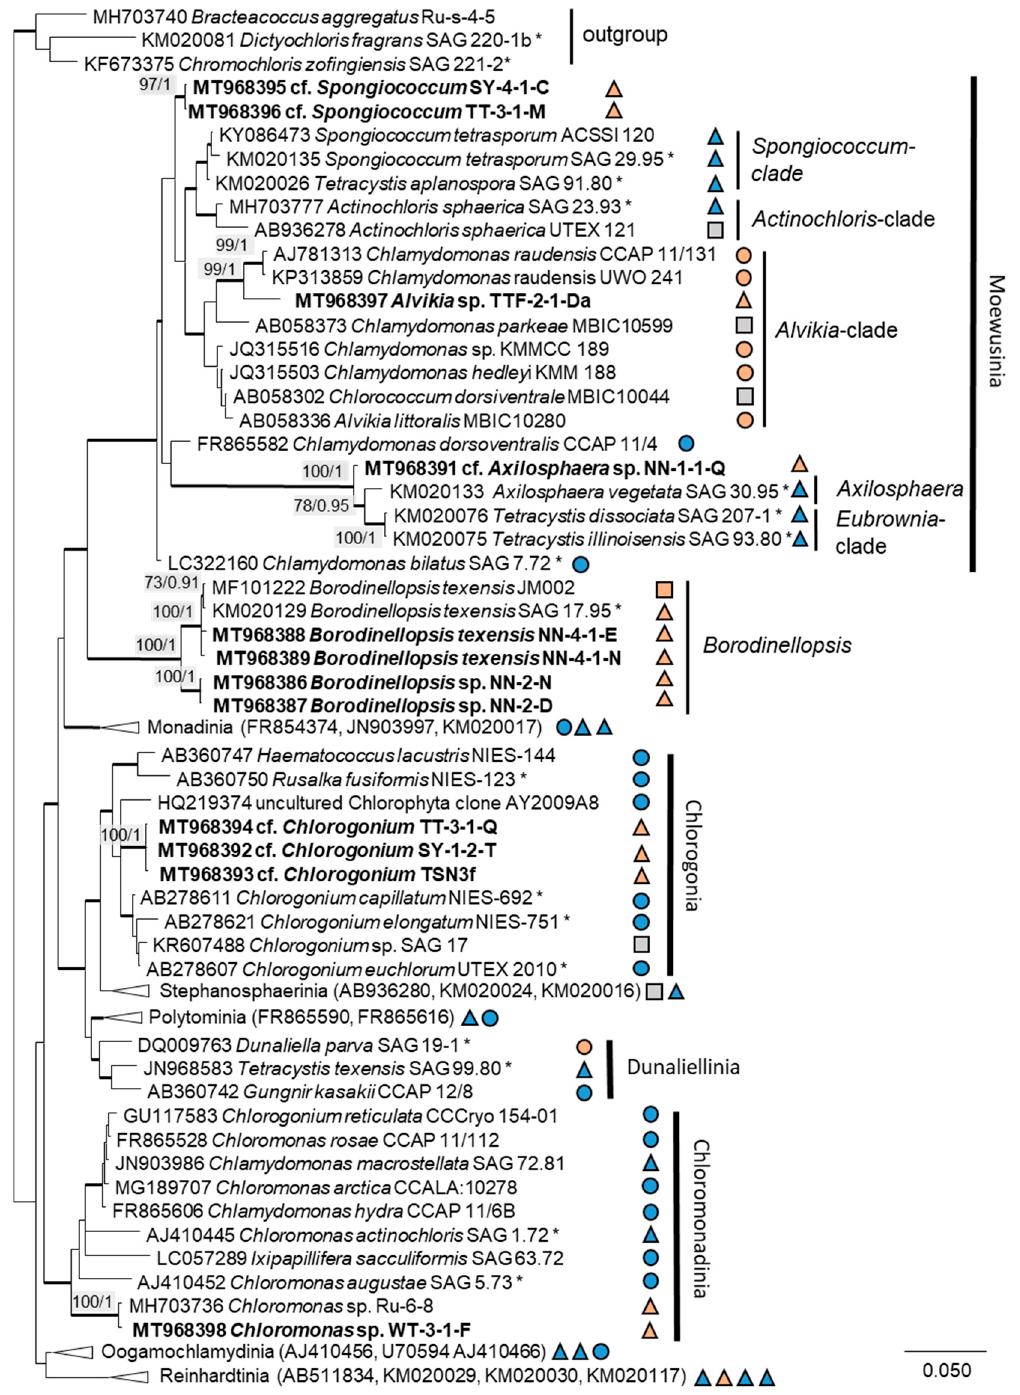
Figure 2. Molecular phylogeny of the Chlamydomonadales based on small subunit ribosomal ribonucleic acid (SSU rRNA) gene sequencing. The phylogenetic tree was calculated by the Bayesian method, including posterior probabilities (PP) with additional maximum likelihood bootstrap values (BP); branches are supported by both methods in bold (BP > 60% and PP > 0.9). Authentic strains were marked with an asterisk, original strains from this study in bold. Habitats of the strains were classified according to habitat type ( Δ terrestrial = absence of permanent water, o aquatic = presence of water, and □ unknown) and saline ( ); nonsaline ( ); and unknown ( ) habitats. Figure 3. Molecular phylogeny of the Sphaeropleales based on SSU rRNA gene sequencing. The phylogenetic tree was calculated by the Bayesian method, including posterior probabilities (PP) with additional maximum likelihood bootstrap values (BP); branches are supported by both methods in bold (BP > 60% and PP > 0.9). Authentic strains were marked with an asterisk, original strains from this study in bold. Habitats of the strains were classified according to habitat type ( Δ terrestrial = absence of permanent water, o aquatic = presence of water, and □ unknown) and saline (